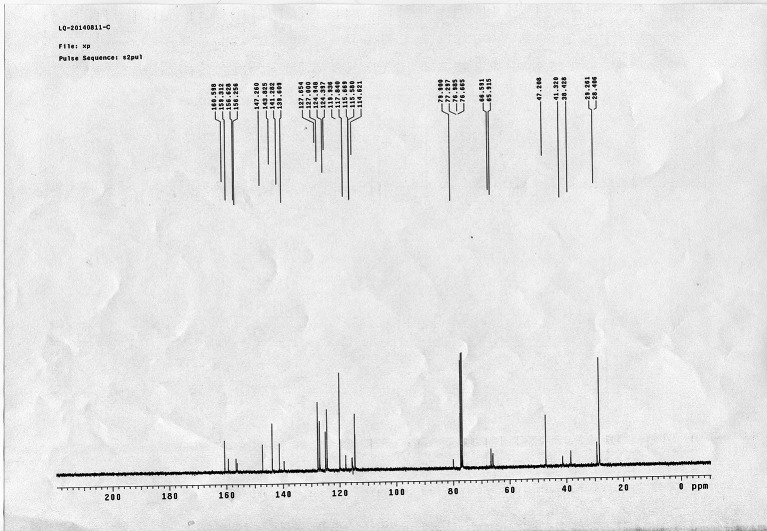
13C NMR spectra of compound 22.